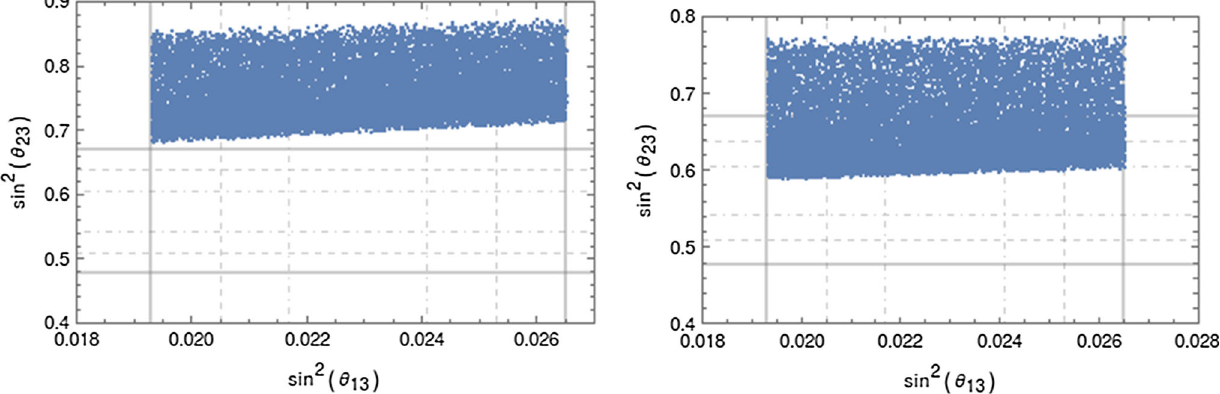
Fig. 1 sin 2 θ 23 versus sin 2 θ 13 . The left and right panels stand for Case C and Case D , respectively. The dot-dashed , dashed and thick lines stand for 1 σ , 2 σ and 3 σ C.L., respectively for each case